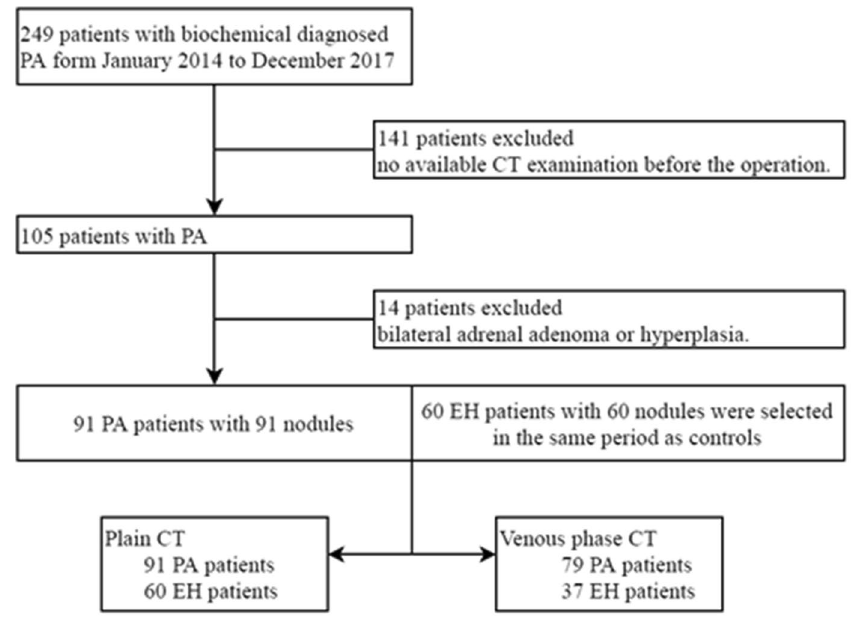
Figure 3. Flow diagram of